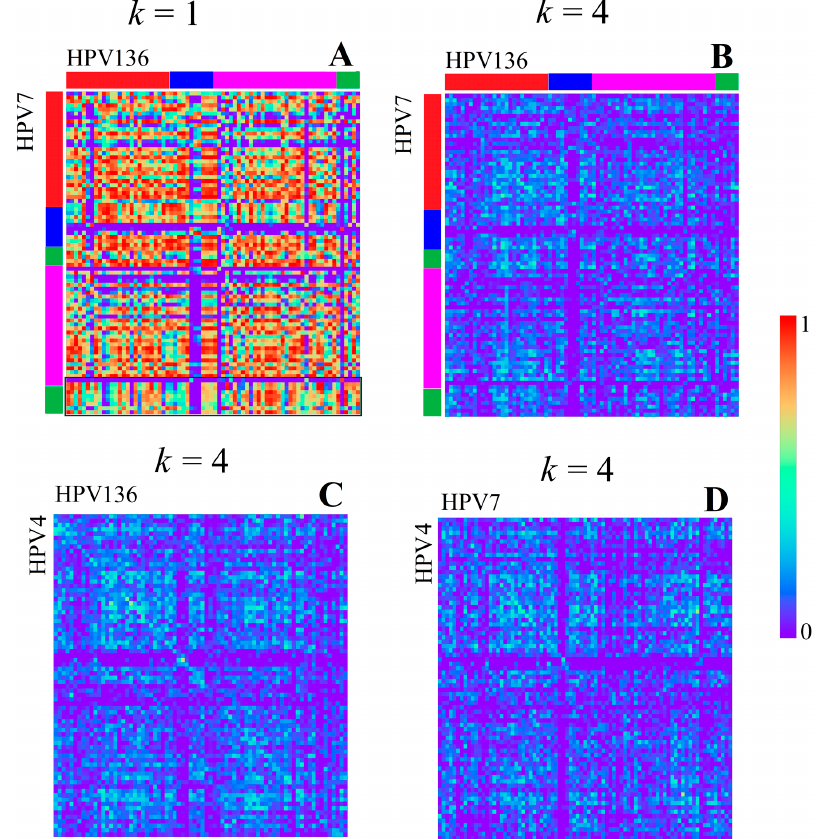
Figure 4. Correlation heatmaps of different HPV types for different k values ( k = 1 in A + C , k = 4 in B + D ), with a bin width of 100 bp. The colored bars at the edges indicate the positions of the top region (red), central region (blue), bottom region (magenta), and NC region (green) according to the borders of associated genes (not by k -mer content). The peculiar structure of the NC region of HPV 7 is highlighted with a green border in ( A , k = 1). The linear structures between HPV4 and HPV136 are considered as “strong” between HPV7 and HPV4, and are “weak” between HPV7 and HPV136.